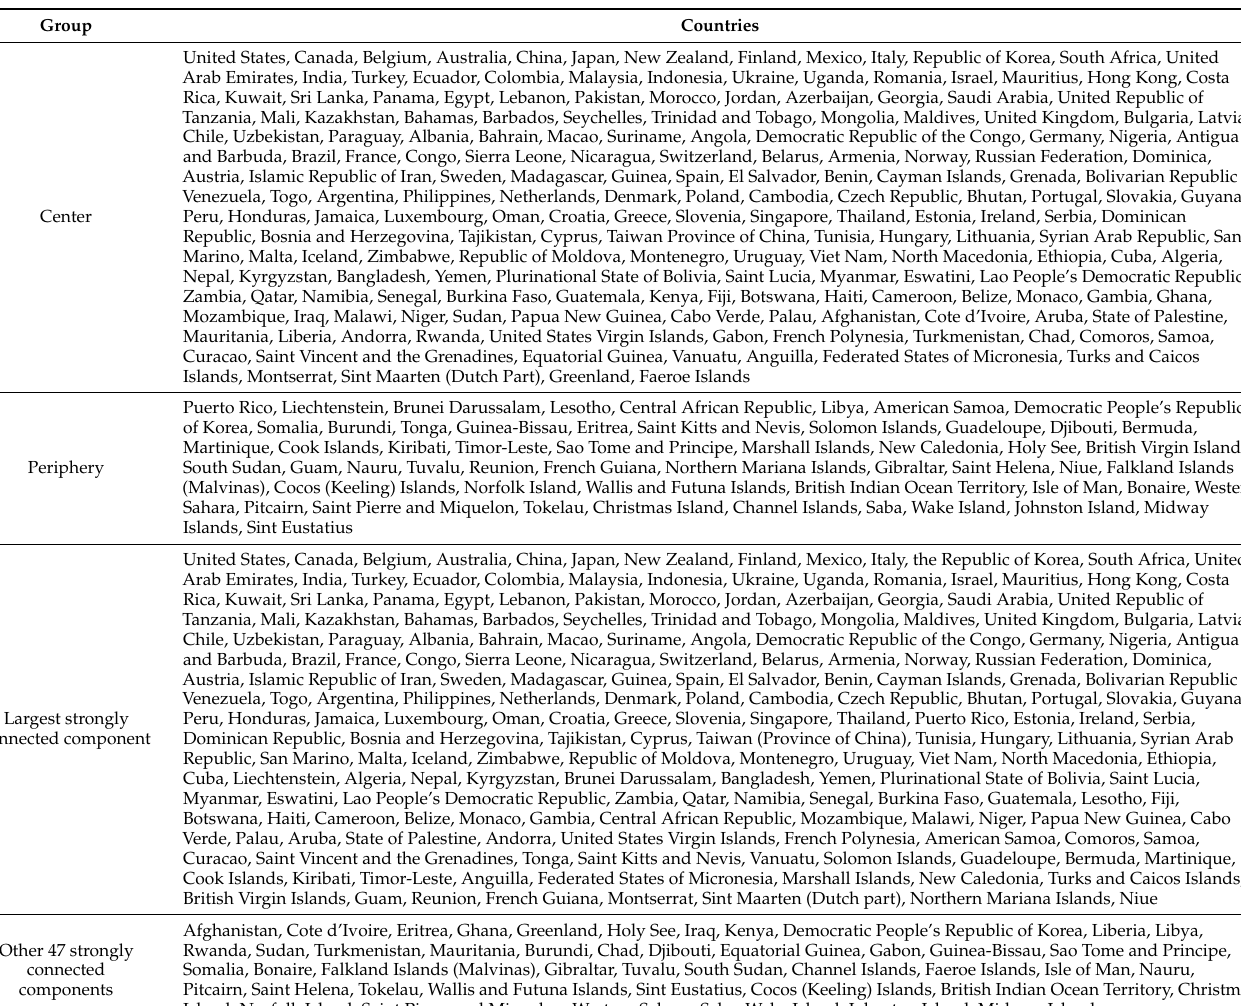
Table A3. Network